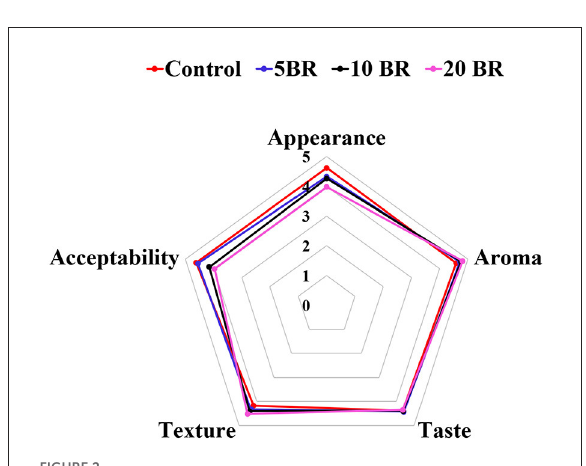
FIGURE2 Sensory evaluation of flaky rolls incorporated with different amounts of black rice